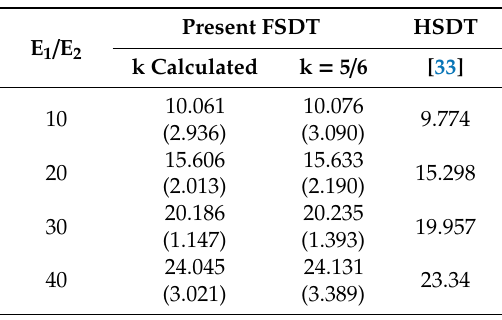
Table 3. Non-dimensional buckling coe ffi cient λ adim .